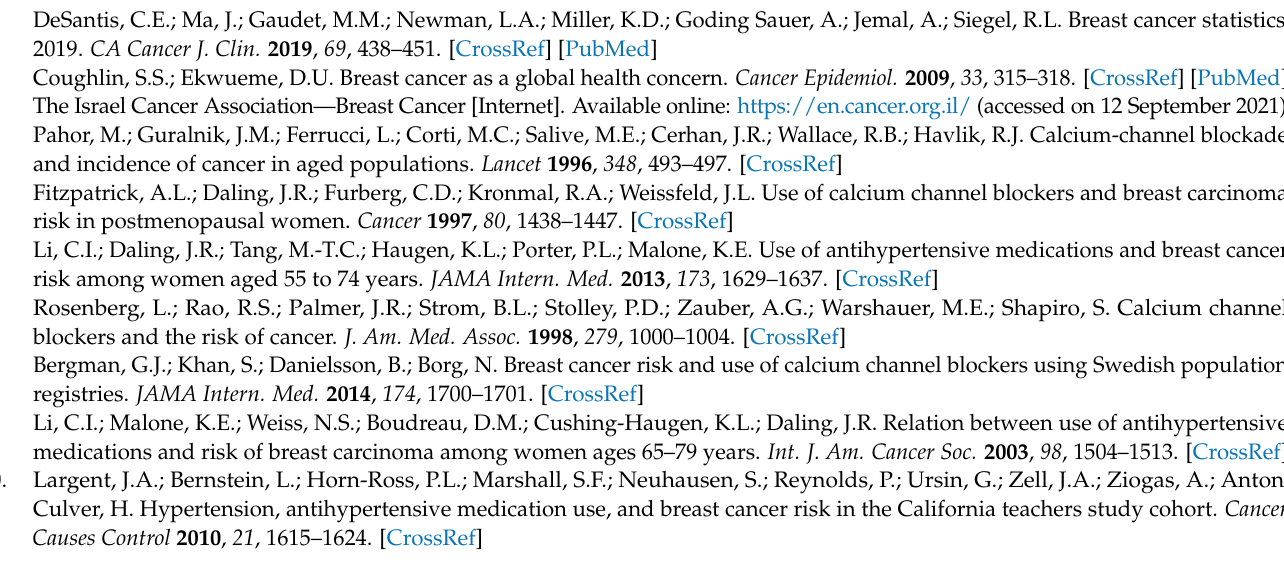
Anatomical Therapeutic and Chemical Index; Table S3: Hormone Replacement Therapy categorized by Anatomical Therapeutic and Chemical Index; Table S4: Evaluation of potential confounders assessed by univariate conditional